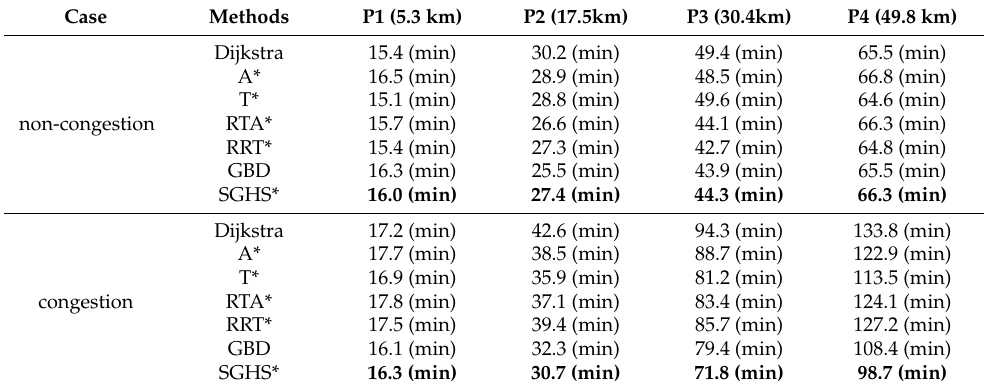
Table 7. Comparison the results of vehicle travel time with clear and congestion in different path